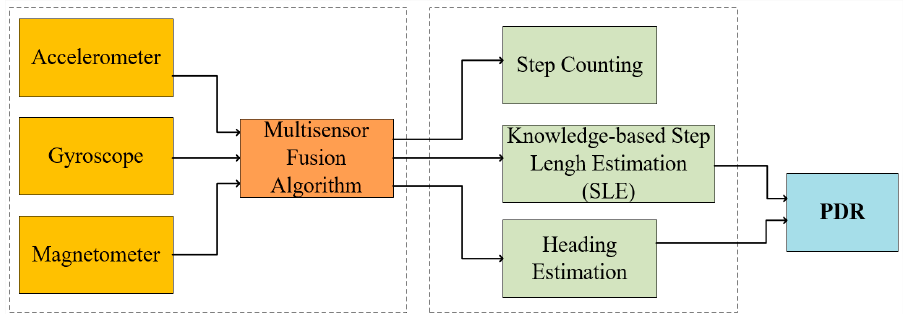
Figure 6. Pedestrian dead reckoning (PDR) scheme.